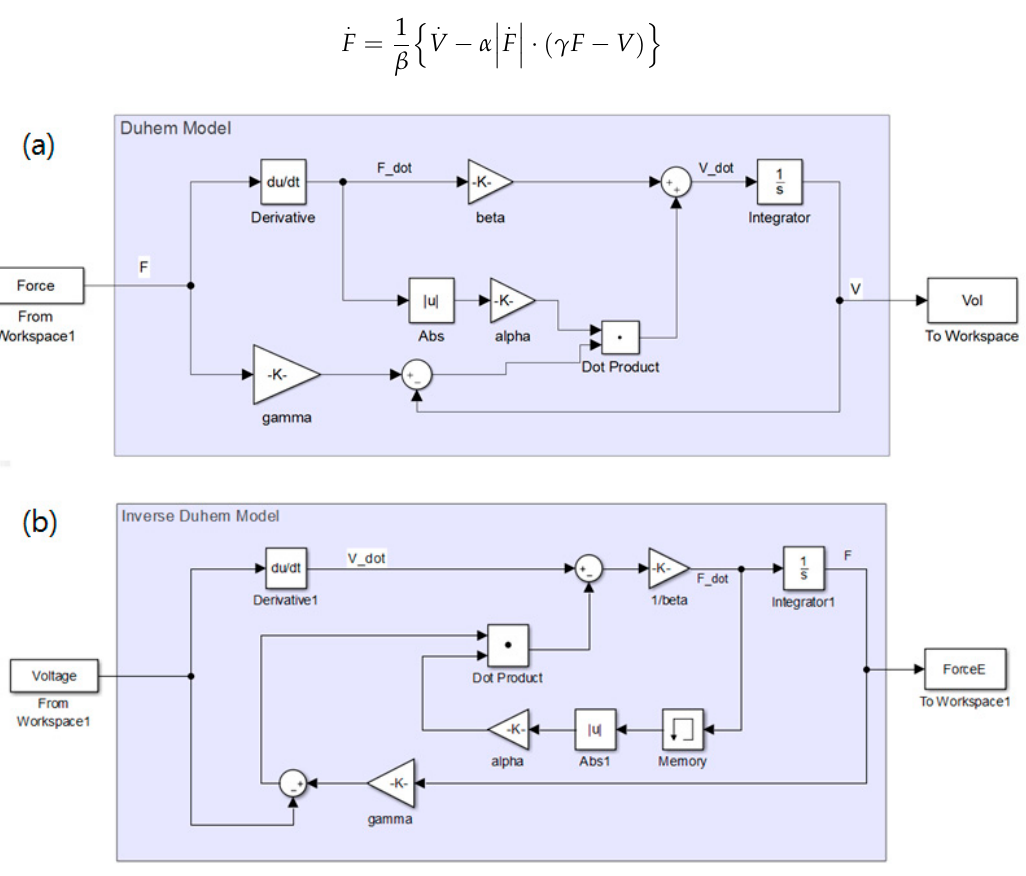
Figure 9. Simulink model. ( a ) semi-linear Duhem hysteresis model and ( b ) inverse model to compensate for the hysteresis.